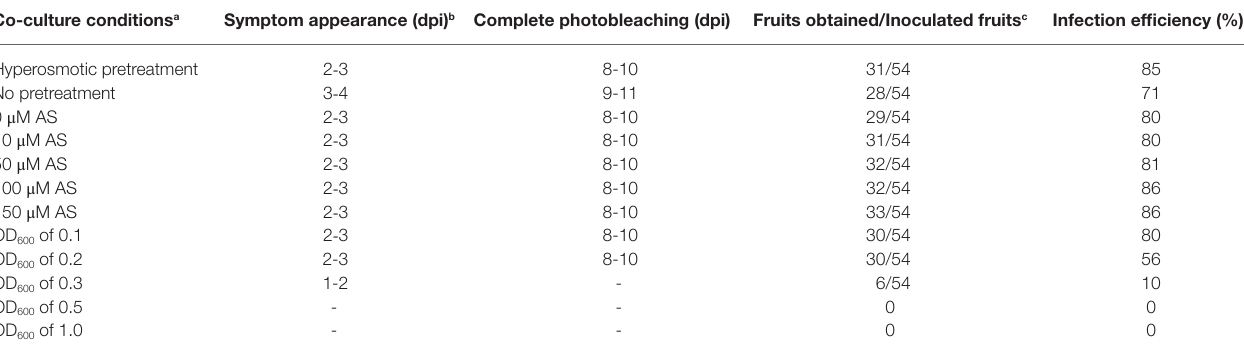
TABLE 1 | JrPDS silencing efficiency in cv. Qingxiang fruits inoculated with pTRV- JrPDS at different co-culture conditions with mature fruits. Co-culture conditions